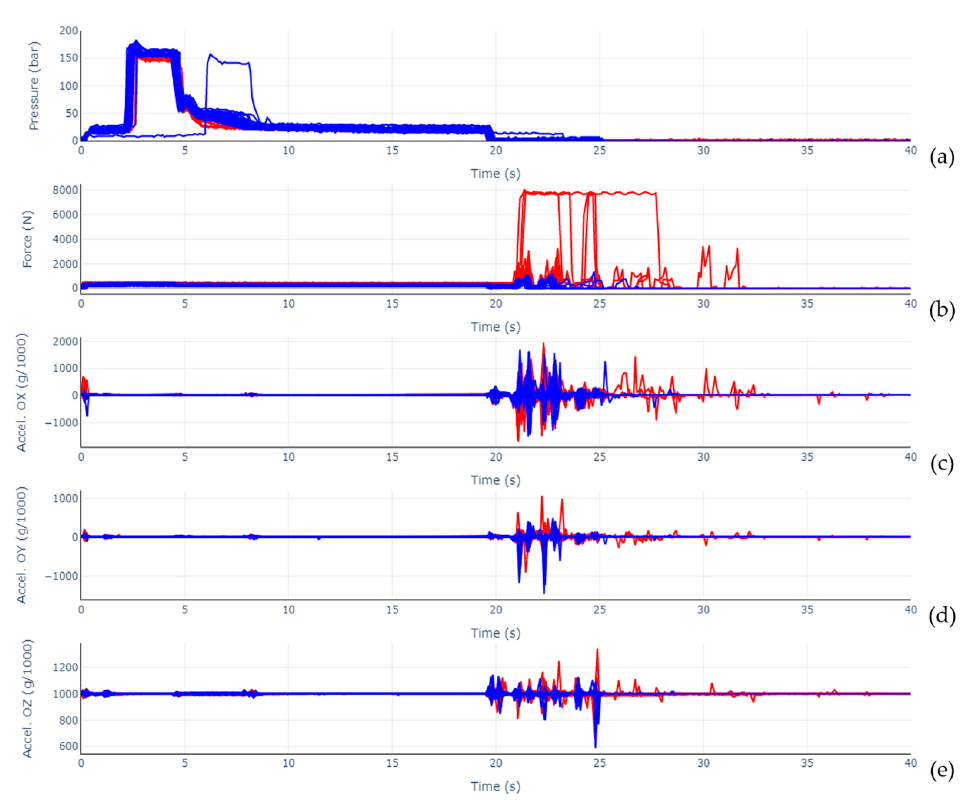
Figure 11. Sensor data for each cycle, overlapped and colored in blue for the regular operation scenario and in red for the simulated fault operation scenario. ( a )—Pressure sensor, ( b )—Force sensor, ( c )—Accelerometer (OX axis), ( d )—Accelerometer (OY axis), ( e )—Accelerometer (OZ